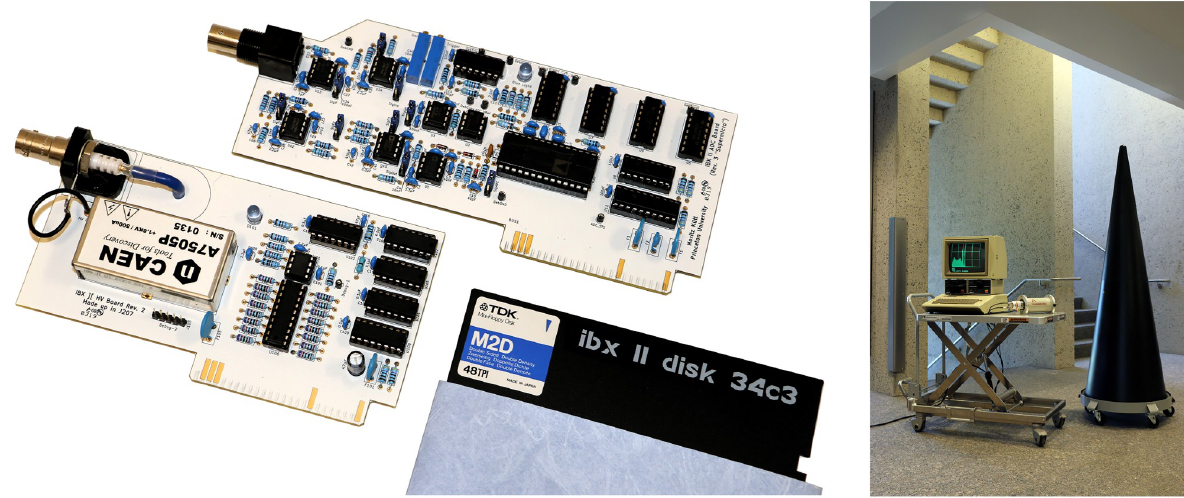
Fig 2. IBX II extension cards (left) and measurement setup with mockup warhead (right). The first card provides high voltage for the photomultiplier, the second card acquires and processes the voltage pulses from the detector. Calibration sources can be emplaced in the mockup warhead to simulate inspection conditions. In practice, warheads or other treaty-limited items may be presented in containerized form.